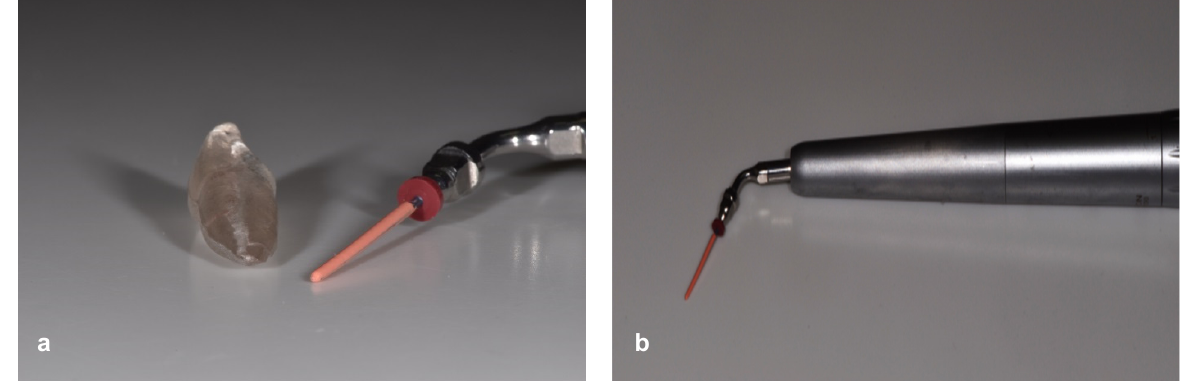
Figure 1. ( a ) Ultrasonic tip designed for the study. ( b ) Handpiece SONIC flex quick 2008/L Air Scaler (KaVo Dental Ltd., Corinium Industrial Estate, Amersham Bucks, UK).